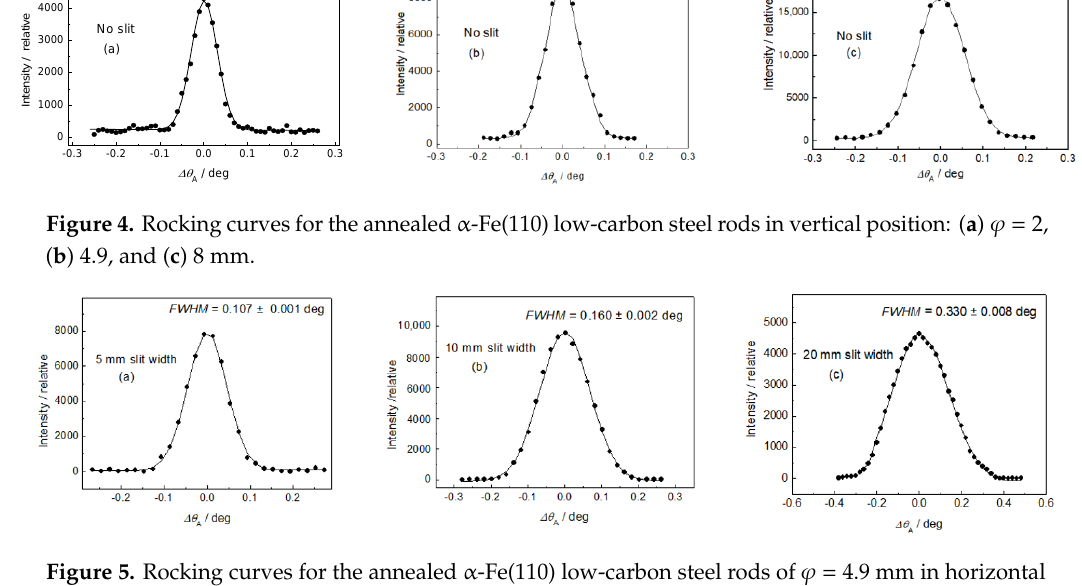
Figure 6. Rocking curves for the annealed α-Fe(110) low-carbon steel rod of  = 8 mm in horizontal position: ( a ) 5, ( b ) 10, and ( c ) 20 mm Cd slits. Figure 7. Rocking curves for the slightly deformed α-Fe(110) low-carbon steel rod of  = 4.9 mm installed in horizontal position for ( a ) 5 mm slit width and ( b ) 10 mm slit width . 4. Discussion The obtained results shown in Figures 5–7 prove that the presented diffraction method provides a sufficiently high angular resolution, represented by the FWHM of the diffraction profile, which allows for the possibility of studying some plastic deformation characteristics (root-mean-square microstrains, as well as the effective grain size), by applying shape analysis on the neutron diffraction peak profiles [11,12]. The advantage of this method permits the investigation of large volumes of polycrystalline samples (several cubic centimeters), thus providing average values of microstructure characteristics over the irradiated gauge volume, e.g., as a function of macroscopic strain loaded on the sample by an auxiliary instrument. Further application of this method can be found in strain/stress studies of textured samples with a large size of grains, as the conventional diffraction method requiring small irradiated gauge volume would be problematic. Naturally, it could also be used for strain scanning in the polycrystalline materials similarly to the conventional two-axis strain/stress scanners when evaluating strains in small gauge volumes (few cubic millimeters) from peak position shifts Δθ S . However, for such measurements, this method would not be practical,